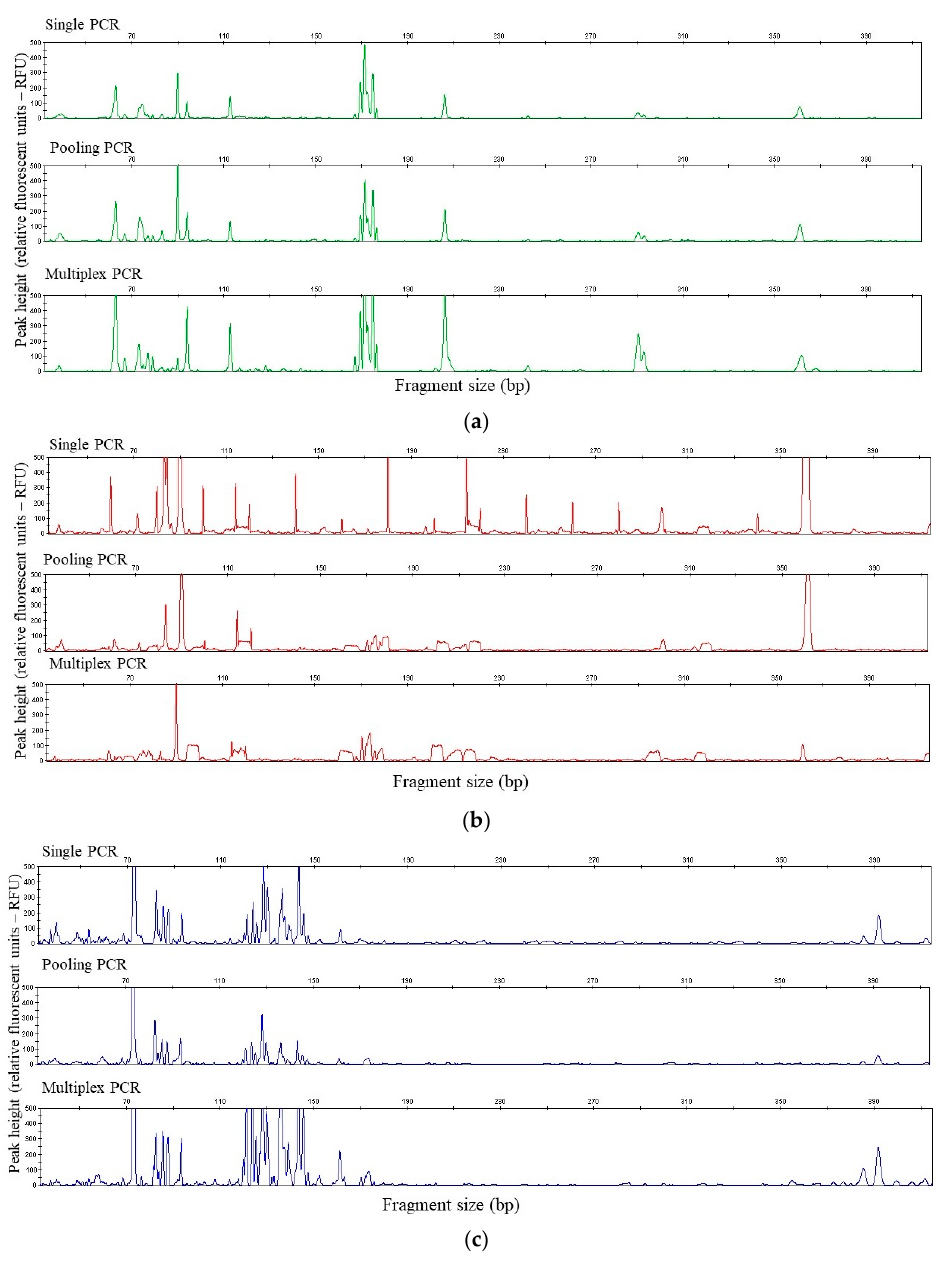
Figure 2. Exemplary electropherograms of the: ( a ) 16S rDNA bacteria, ( b ) 16S rDNA archaea and ( c ) ITS1 fungi T-RFs after digestion with the endonuclease HaeIII.